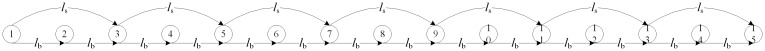
Bus and subway corridor.